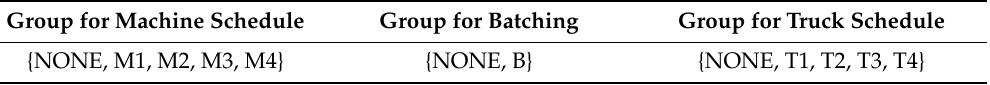
Table 2. Grouped neighborhood